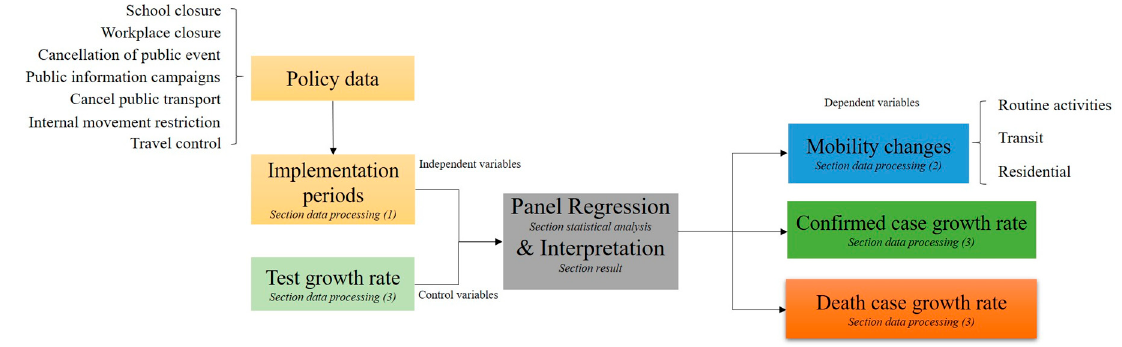
Figure 1. The workflow of the policy